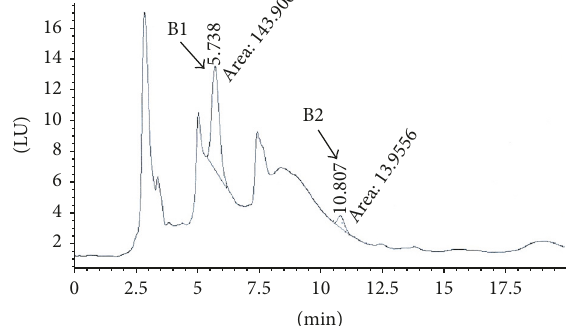
Figure 5: HPLC chromatogram of chocolate sample.